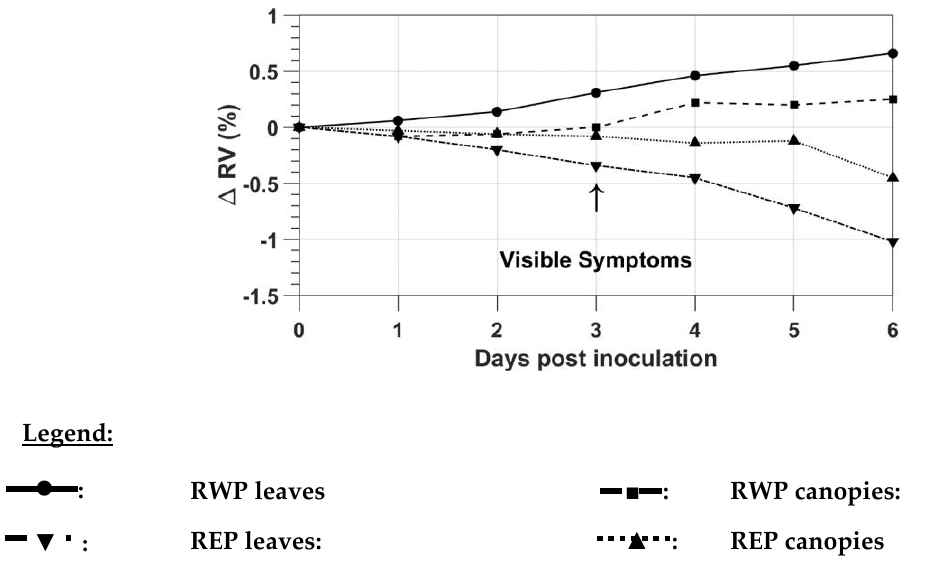
Figure 9. Variation of ∆ RV (in %) computed using the mean red-well point (RWP) and red-edge point (REP) values of infected and healthy leaves and canopies as a function of the days post-inoculation.